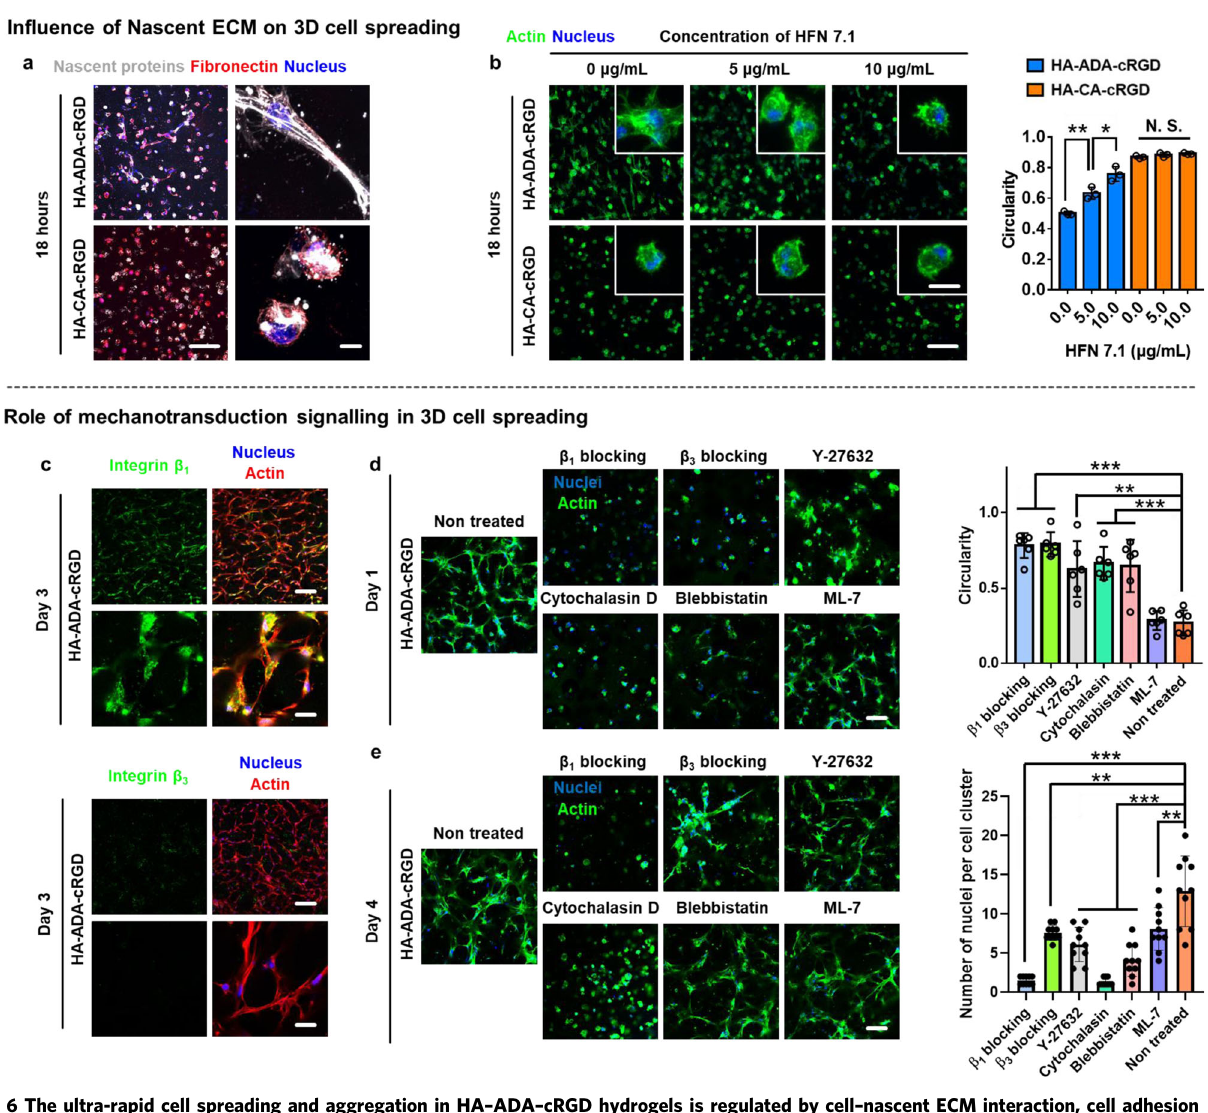
mean values ± SD, n = 3 independent hydrogels, * p < 0.05, ** p < 0.01 (two-tailed Student ’ s t -test). c Representa t ive immuno fl uorescence staining against F-actin (red), nuclei (blue), and β 1 class integrins or β 3 class integrins (green) in hMSCs cultured in highly dynamic HA – ADA – cRGD hydrogels for 3 days (images on the top: scale bar = 200 μ m. Images on the bottom: scale bar = 50 μ m). d Cell spreading in the highly dynamic HA – ADA – cRGD hydrogels after 1 day of culture with or without treatment with integrin-blocking antibodies, a myosin inhibitor (blebbistatin), a myosin light chain kinase inhibitor (ML-7), a ROCK inhibitor (Y-27632), or an inhibitor of actin polymerization (Cytochalasin D). Scale bar = 100 μ m. The circularity of the hMSCs encapsulated within the hydrogels treated with different inhibitors. (The average circularity value is calculated according to C = 4 π A / P 2 , where A is the area occupied by the cell and P is the perimeter of the cell). Data are presented as mean values± SD, n = 10 cells per group from two independent hydrogels; ** p < 0.01, *** p < 0.001 (two-tailed Student ’ s t -test). e Multi-cell assembly in the highly dynamic HA – ADA – cRGD hydrogels after 4 days of culture with or without treatment with blocking antibodies and inhibitors. Scale bar = 100 μ m. The quanti fi cation of the multicellularity of the cell clusters within the hydrogels treated with different inhibitors. Data are presented as mean values± SD, n = 10 cell clusters per group from two independent hydrogels; ** p < 0.01, *** p < 0.001 (two- tailed Student ’ s t